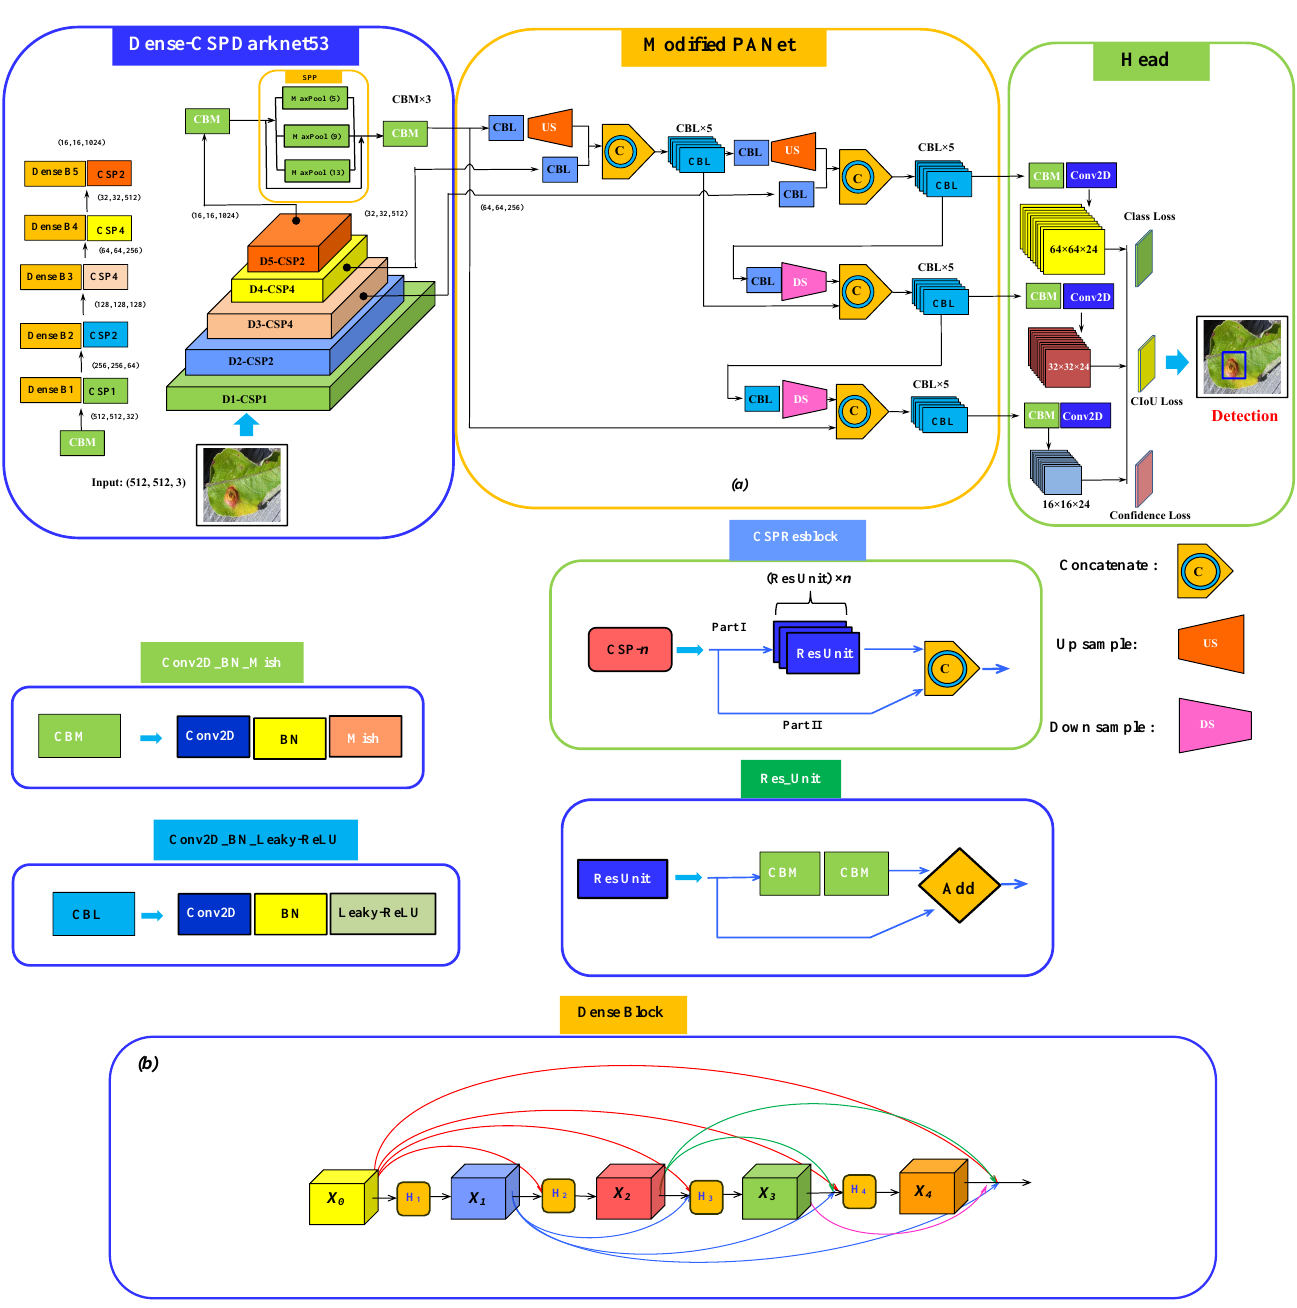
Figure 2. Schematic of ( a ) the proposed network architecture for plant disease detection consisting of Dense-CSPDarknet53 integrating SPP as the backbone, modified PANet as a neck with a regular YOLOv3 head; ( b ) dense block